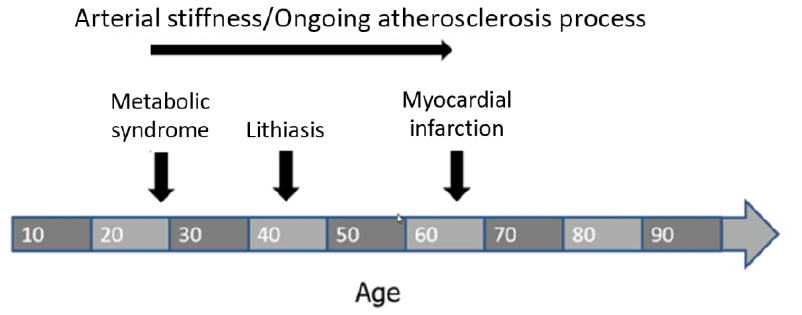
Figure 2. Temporal relationship between MS, stone episodes and CV events.